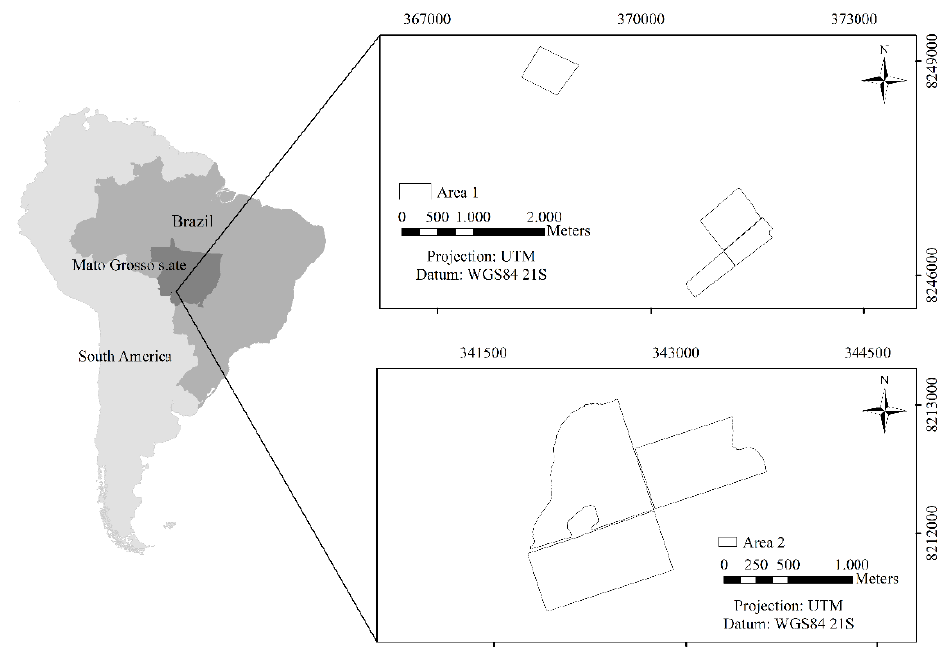
Figure 1. Study areas with Tectona grandis stands, in the western region of Mato Grosso state, Brazil.